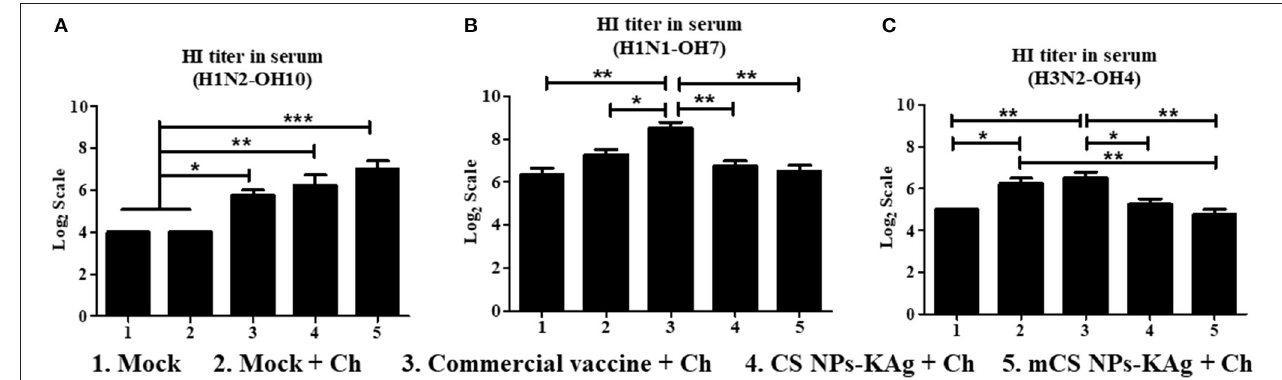
FIGURE 4 | Hemagglutination inhibition (HI) antibody titers in MDA-positive pigs vaccinated with mannose-conjugated and unconjugated CS NPs based influenza (mCS NPs-KAg and CS NPs-KAg) or commercial flu vaccine and challenged at day post vaccination 35 with the H1N1-OH7 virus. On day six post challenge HI antibody titer in serum against (A) H1N2-OH10; (B) H1N1-OH7; and (C) H3N2-OH4 viruses were measured. Data represent the mean value of three to four pigs ± SEM. Statistical analysis was carried out using one-way ANOVA followed by Tukey’s post hoc comparison test. Asterisk refers to statistical difference between the two indicated groups (* p < 0.05, ** p < 0.01, and *** p < 0.001). Ch, Challenge.